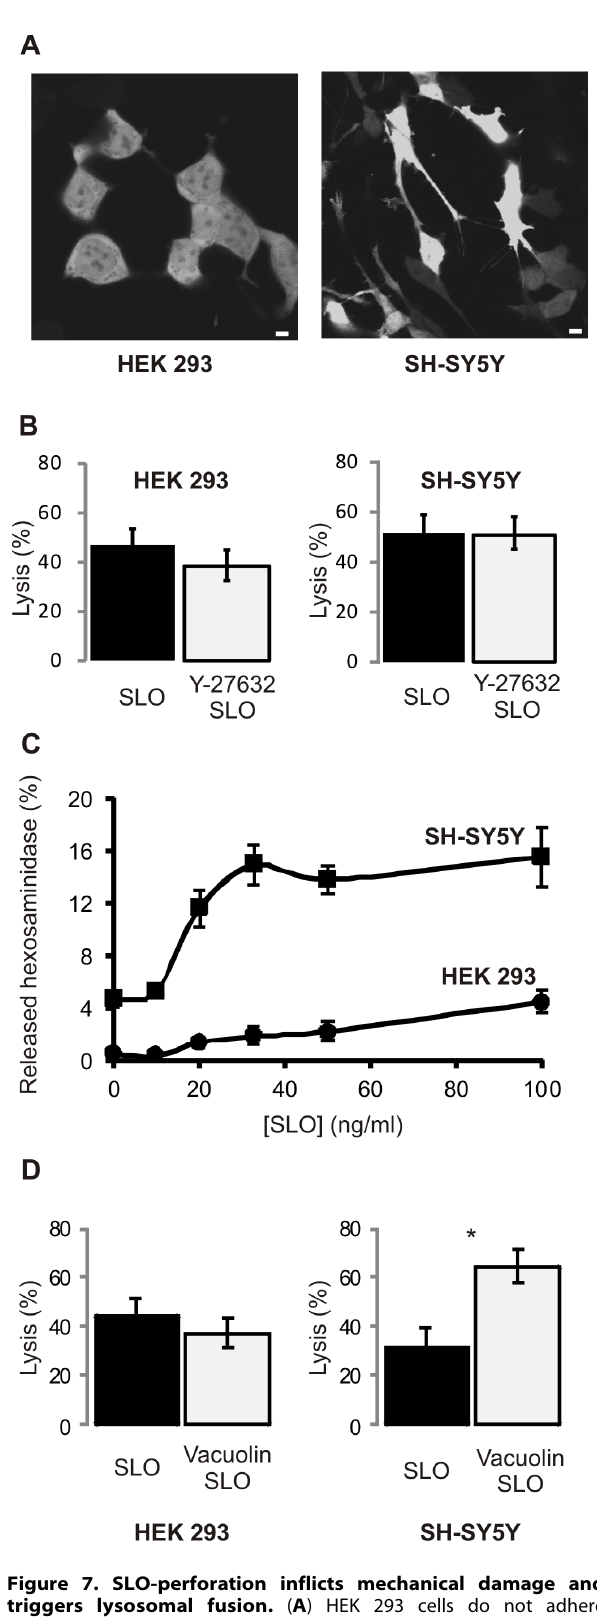
Figure 7. SLO-perforation inflicts mechanical damage and triggers lysosomal fusion. ( A ) HEK 293 cells do not adhere extensively to the substratum at the cellular periphery while SH-SY5Y cells are firmly attached by multiple protrusions. Magnification bars=2 m m. ( B ) Inhibition of myosin contraction does not protect from SLO induced lysis. ( C ) Lysosomal exocytosis ( b